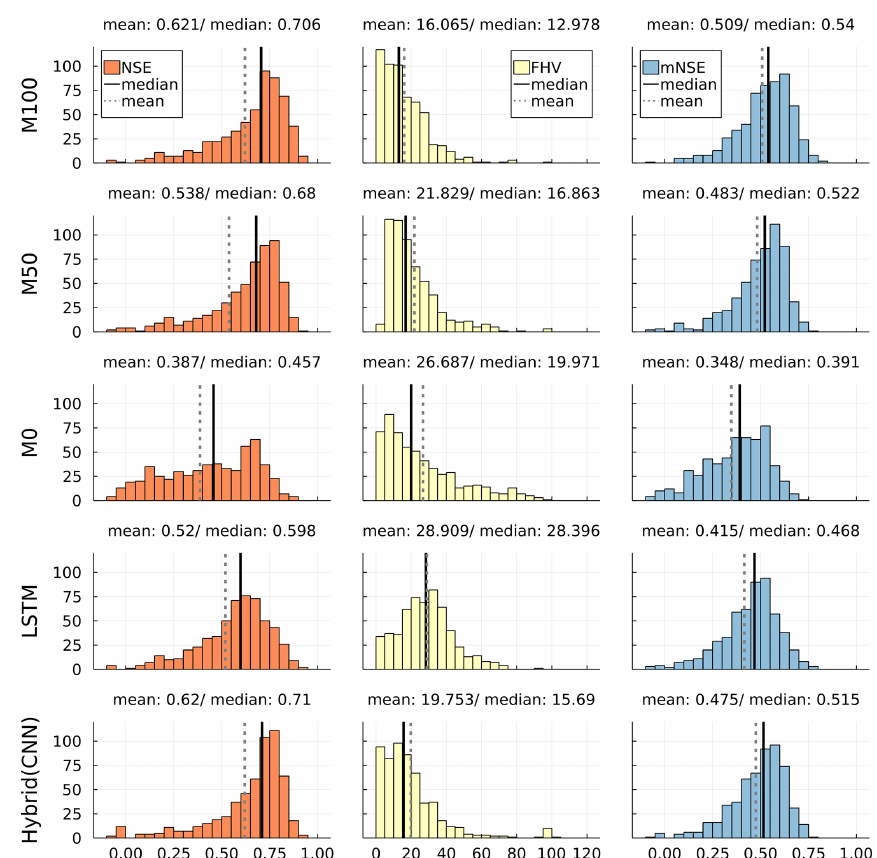
Figure 2. Histograms of NSE (orange; optimal value: 1), FHV (yellow; optimal value: 0) and mNSE (blue; optimal value: 1) for the developed neural ODE models M100 and M50, the plain conceptual baseline model M0 and state-of-the-art LSTM and postprocessing hybrid CNN models (bottom; cf. Jiang et al.,